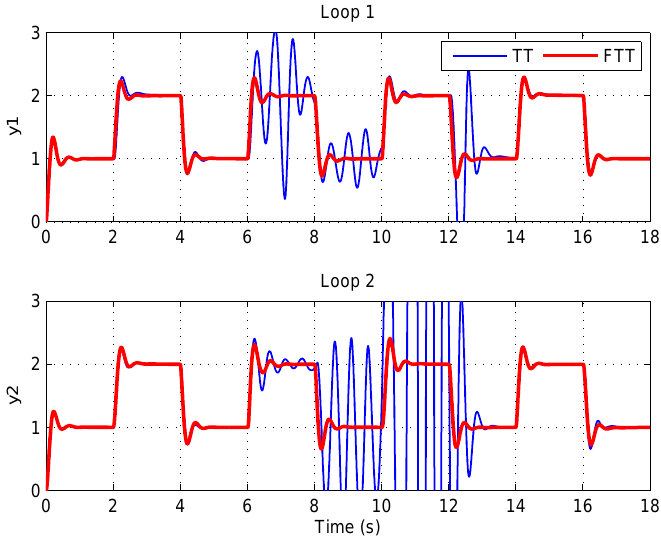
Figure 10. System output under severe